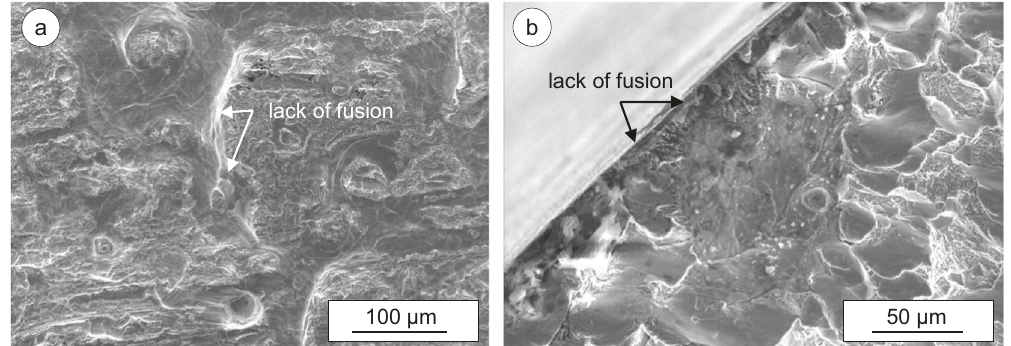
Fig. 6 Fracture surfaces with LOF defects. a Fatigued EBM specimen (400 MPa, 2.5 × 10 3 cycles) with areas of LOF, b fatigued EBM specimen (325 MPa, 3.4 × 10 4 cycles) with areas of LOF at the specimens